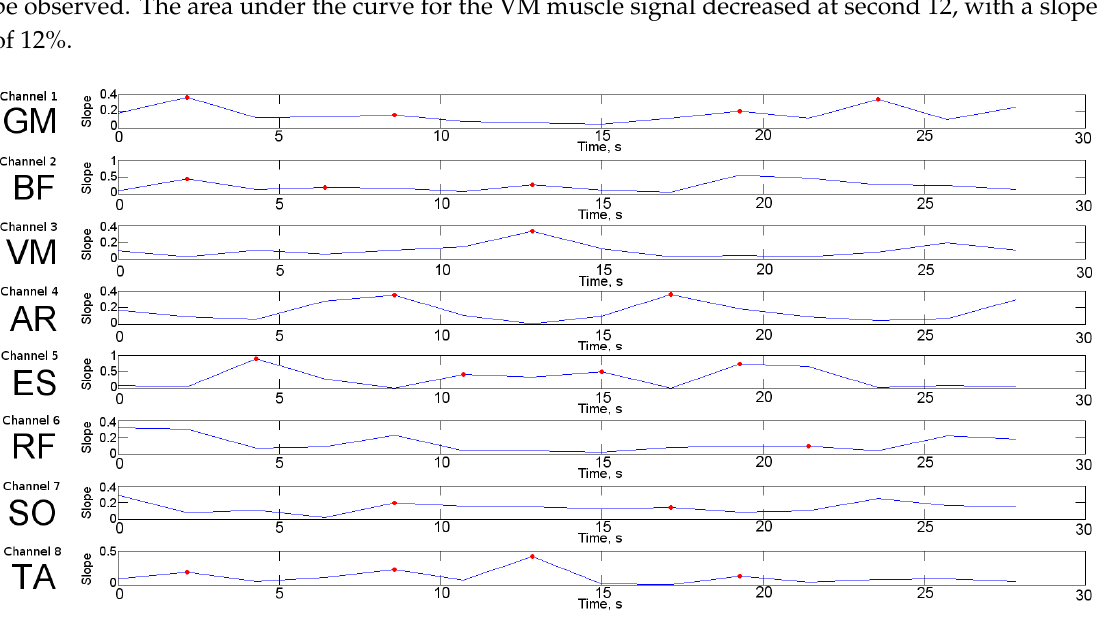
Table 1. Electromyographic descriptive variables (mean, SD).